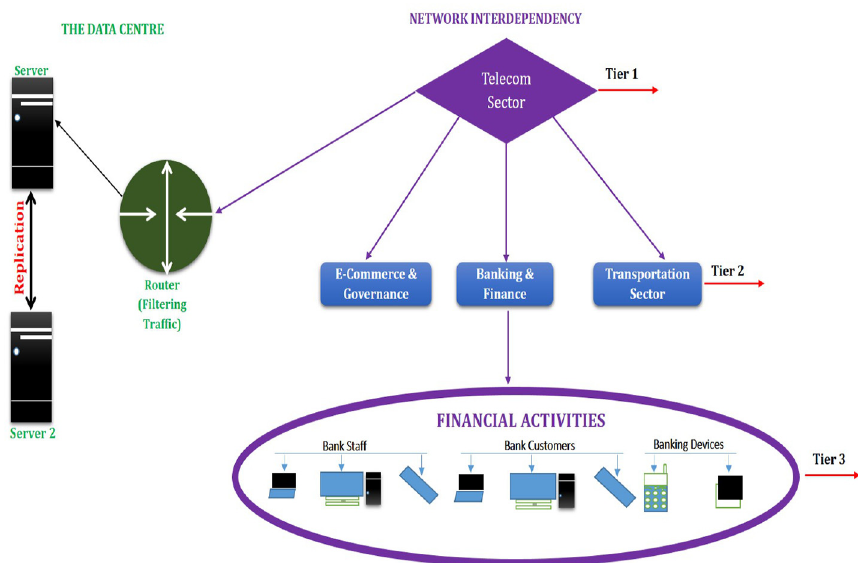
Figure 5. Architecture of the fail-safe